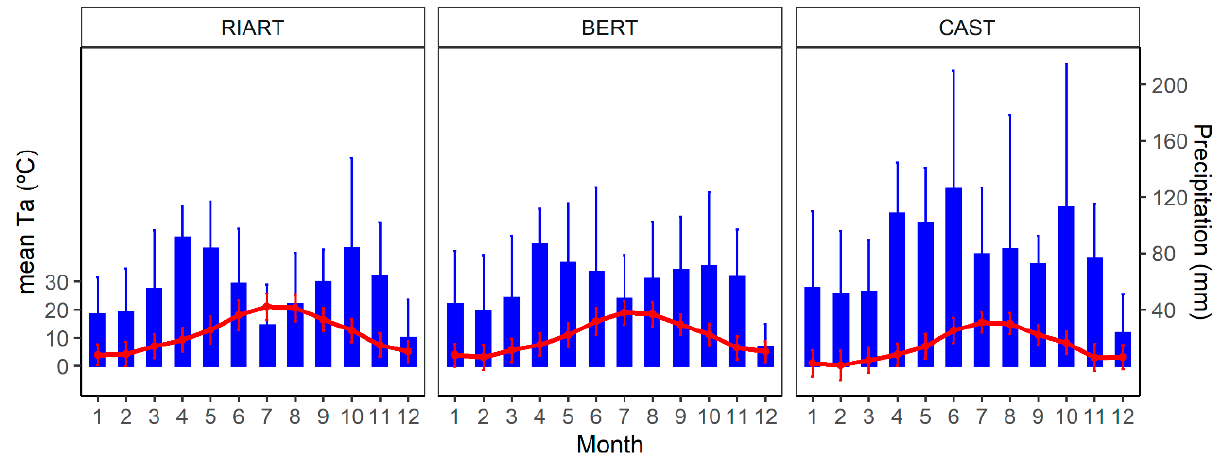
Figure 2. Climogram of the study sites, mean air temperature (T a ), and precipitation. Data sources: T a , eddy covariance flux stations from the period 2012–2020; precipitation from the closest meteorological stations of the Servei Meteorologic de Catalunya (see Annex